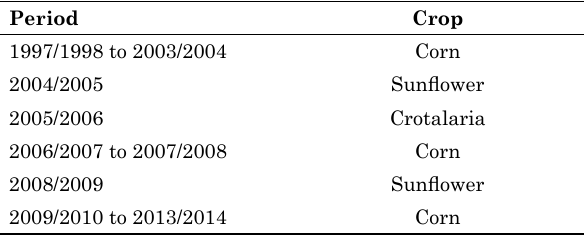
table 2. Crop plants tested in eutroferric and dystrophic Latossolos Vermelhos (oxisol), which have been fertilized with sewage sludge